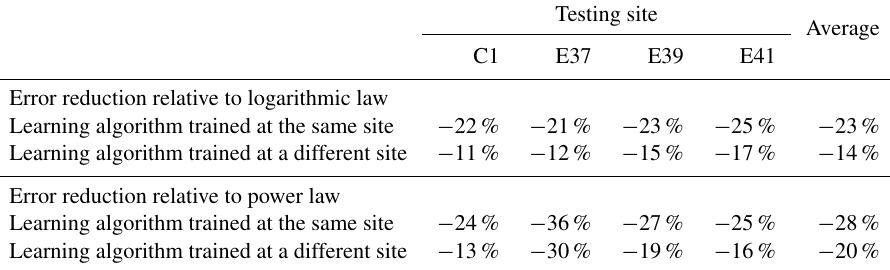
Table 4. Percentage reduction in wind speed extrapolation MAE from the random-forest approach over the logarithmic law and power law. Testing site Average C1 E37 E39 E41 Error reduction relative to logarithmic law Learning algorithm trained at the same site − 22% − 21% − 23% − 25% − 23% Learning algorithm trained at a different site − 11% − 12% − 15% − 17% − 14% Error reduction relative to power law Learning algorithm trained at the same site − 24% − 36% − 27% − 25% − 28% Learning algorithm trained at a different site − 13% − 30% − 19% −